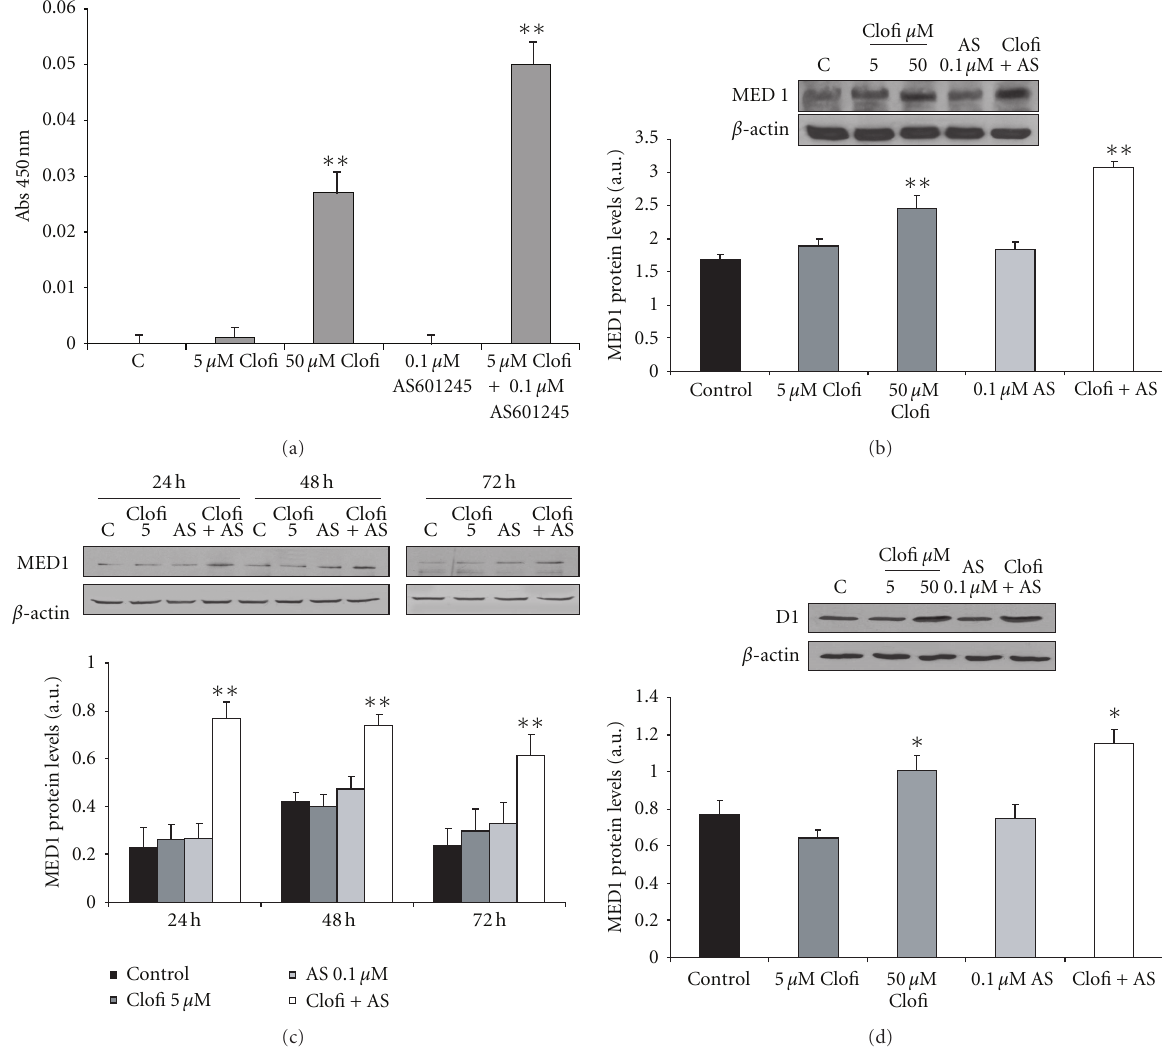
Figure 6: PPRE binding activity and Western Blot analysis of Med1 and cyclin D1. (a) PPRE binding activity of PPAR α . Results represent the absorbance, detected at 450 nm, subtracted from the control value, and are the mean ± SD of three separate experiments from three di ff erent preparations for each condition; (b) Western Blot analysis of Med1 protein detected in CaCo-2 cells treated with 5 μ M and 50 μ M clofibrate (Clofi), 0.1 μ M AS1245, and 5 μ M clofibrate plus 0.1 μ M AS601245 (Clofi + AS601245), collected at 24 hours after the treatment; (c) Western Blot analysis of Med1 protein detected in CaCo-2 cells treated with 5 μ M clofibrate, 0.1 μ M AS1245, and 5 μ M clofibrate plus 0.1 μ M AS601245 (Clofi + AS), collected at 24, 48, and 72 hours after the treatment; (d) Western Blot analysis of cyclin D1 detected in CaCo- 2 cells treated with 5 μ M and 50 μ M clofibrate (Clofi), 0.1 μ M AS1245, and 5 μ M Clofibrate plus 0.1 μ M AS601245 (Clofi + AS601245), collected at 24 hours after the treatment. Graphics represent the relative quantification of protein products performed by densitometric scanning. Data were normalized by using the β -actin signal, expressed as arbitrary densitometric units, and are the mean ± SD of three separate experiments from three di ff erent preparations for each condition. Variance analysis: ∗ P < 0 . 05, ∗∗ P < 0 . 01 versus